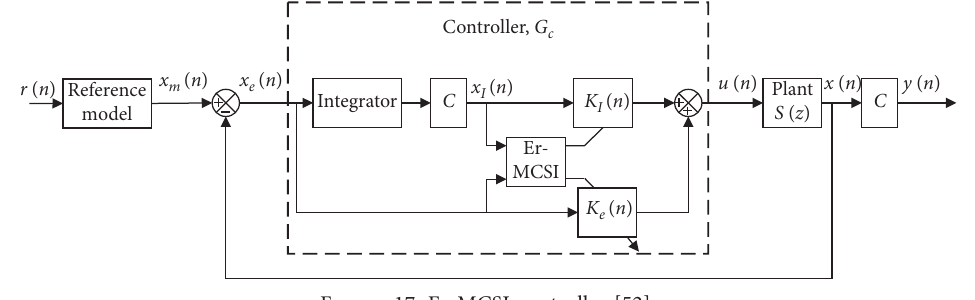
Figure 16: Extended FXLMS algorithm [137].